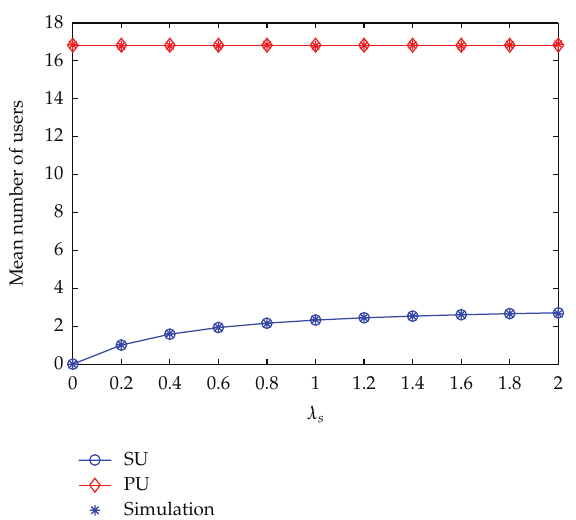
Figure 2: Expected number of users in SUC mode versus λ s . The system parameters are N (cid:8) 20, μ p (cid:8) μ s and λ p (cid:8) 1.